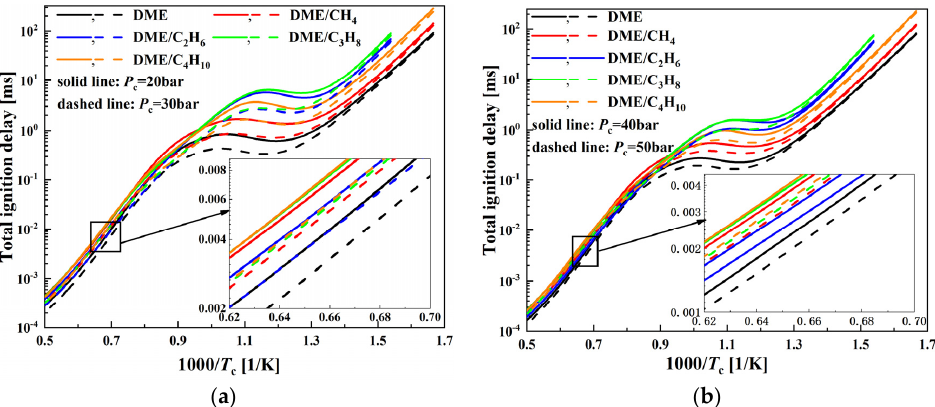
Figure 3. Comparison of ignition delay of DME/C1-C4 alkane mixtures for various compressed pressures at ϕ = 0.5: ( a ) P c = 20, 30 bar and ( b ) P c = 40, 50 bar.